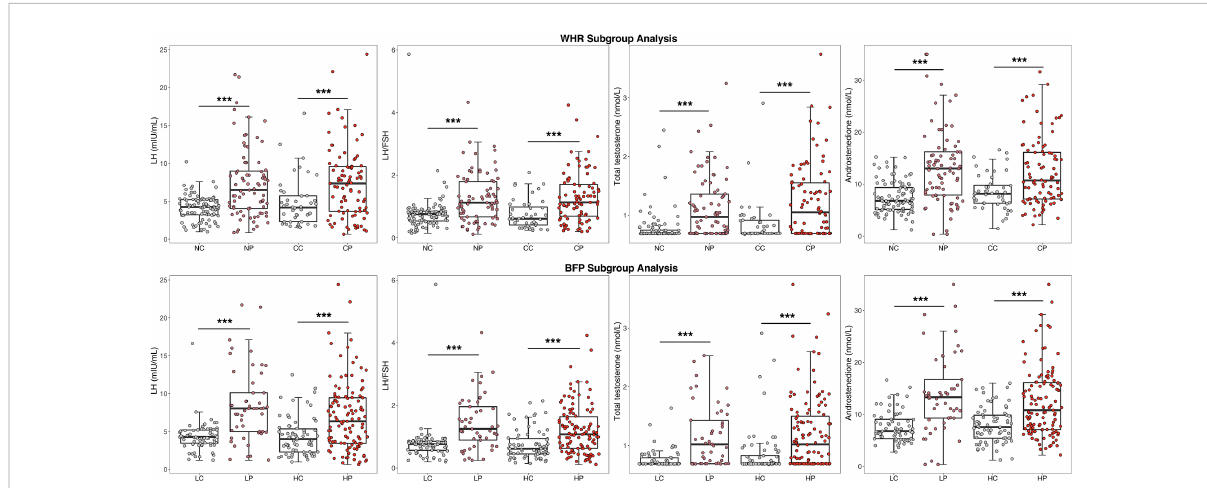
FIGURE 2 Comparison of endocrine indicators after WHR and BFP strati fi cation a . a WHR, Waist-to-hip ratio; BFP, Body fat percentage; CP, Central obese PCOS group; CC, Central obese control group; NP, Non-central obese PCOS group; NC, Non-central obese control group; HP, High body fat percentage PCOS group; HC, High body fat percentage control group; LP, Low body fat percentage PCOS group; LC, Low body fat percentage control group; FSH, follicle stimulating hormone; LH, luteinizing hormone. * p < 0.05, ** p < 0.01, *** p <